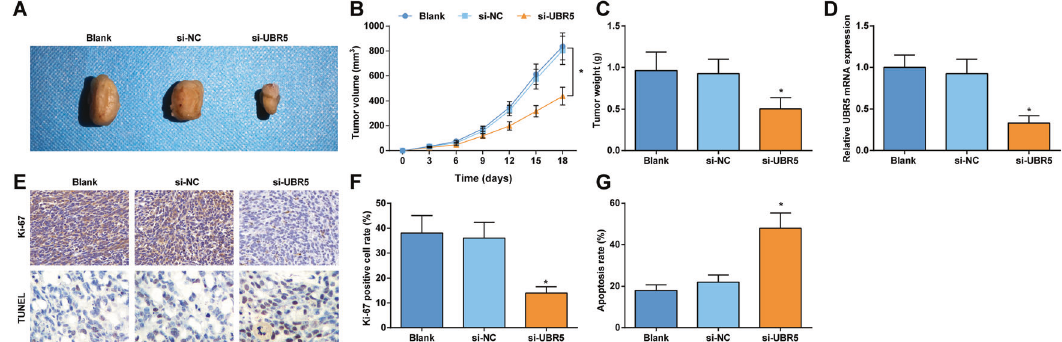
Fig. 7 Downregulating UBR5 impedes gliomas tumor growth in mice. A Tumors of nude mice. B Tumor volume of mice. C Tumor weight of mice. D RT-qPCR detected UBR5 expression in mouse tumors. E Ki-67 immunohistochemical staining results (400×) and TUNEL staining (400×) of tumor tissues of mice. F Ki-67-positive cells in tumor tissues of mice. G Apoptosis rate of cell in tumor tissues of mice; n = 8/group; the data were all measurement data, in the form of mean ± standard deviation; * P < 0.05 compared with the si-NC